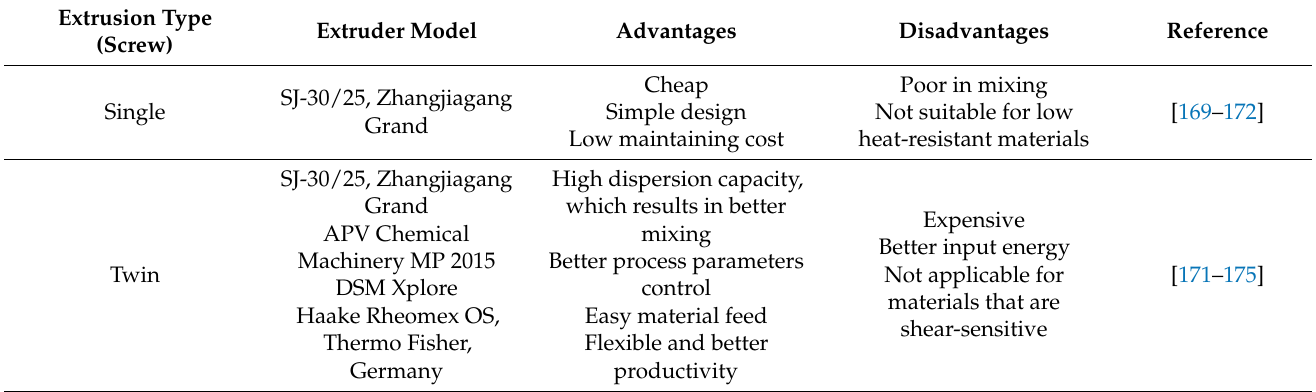
Table 3. Single screw and twin screw are compared.